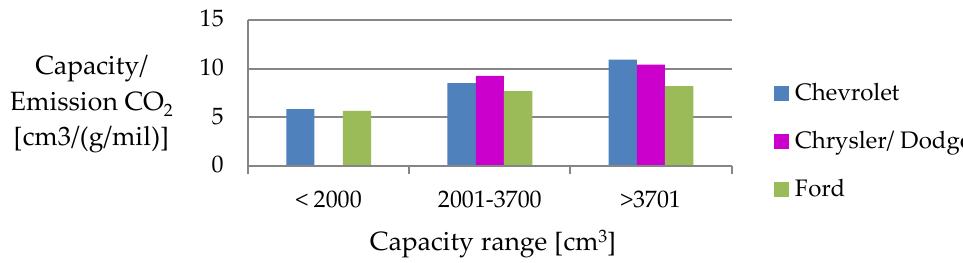
Figure 17. Ratio of capacity to carbon dioxide emissions in individual engine capacity ranges among